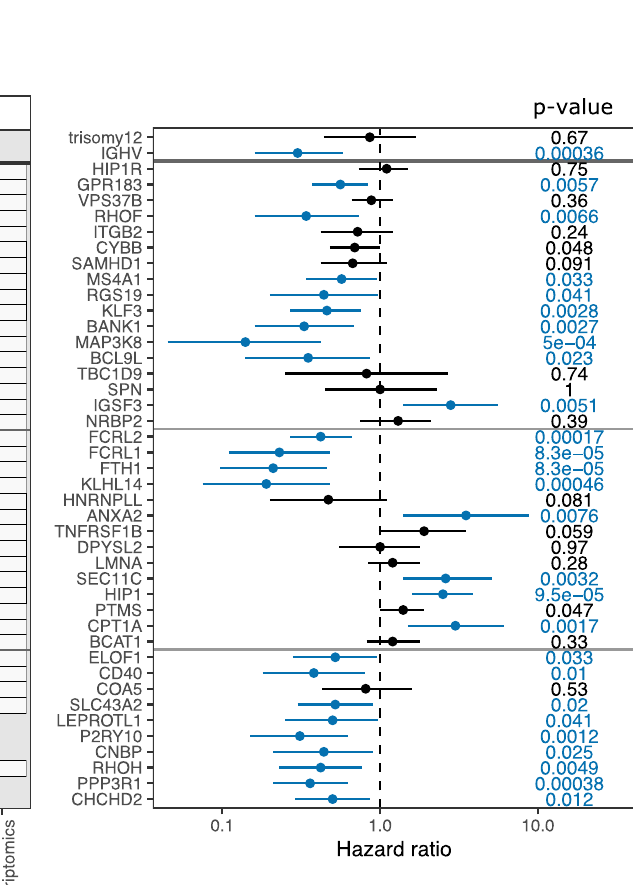
transcripts, and proteins with the strongest weights loadedonto LF1, LF2, and LF9. Weights were scaled between genetics (divided by two), proteomics, and tran- scriptomics (times ten) to achieve similar ranges. d Hazard ratios from Cox regression for TTNT with genes and proteins with strong weights for LF1, LF2, and LF9. Signi fi cant associations ( p <0.05) are colored in blue. P values (Wald-test) are shown on the right. Mean and 95% con fi dence intervals are shown. n =72 biologi- cally independent patient samples. Source data are provided as a Source Data fi